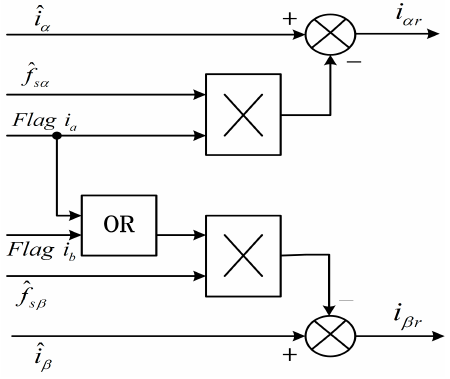
Figure 1. αβ axis current fault processing module.